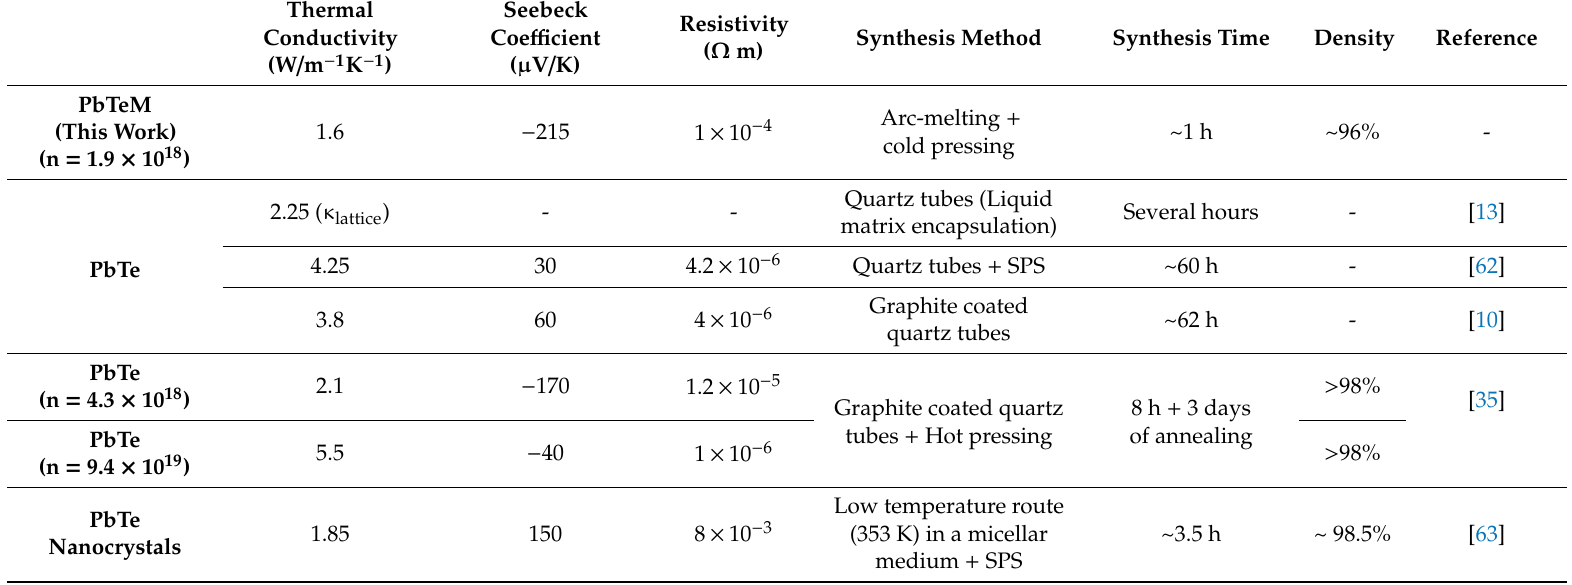
Table 2. Comparison of lead telluride thermoelectric properties obtained by di ff erent synthesis processes. All data are measured at 300